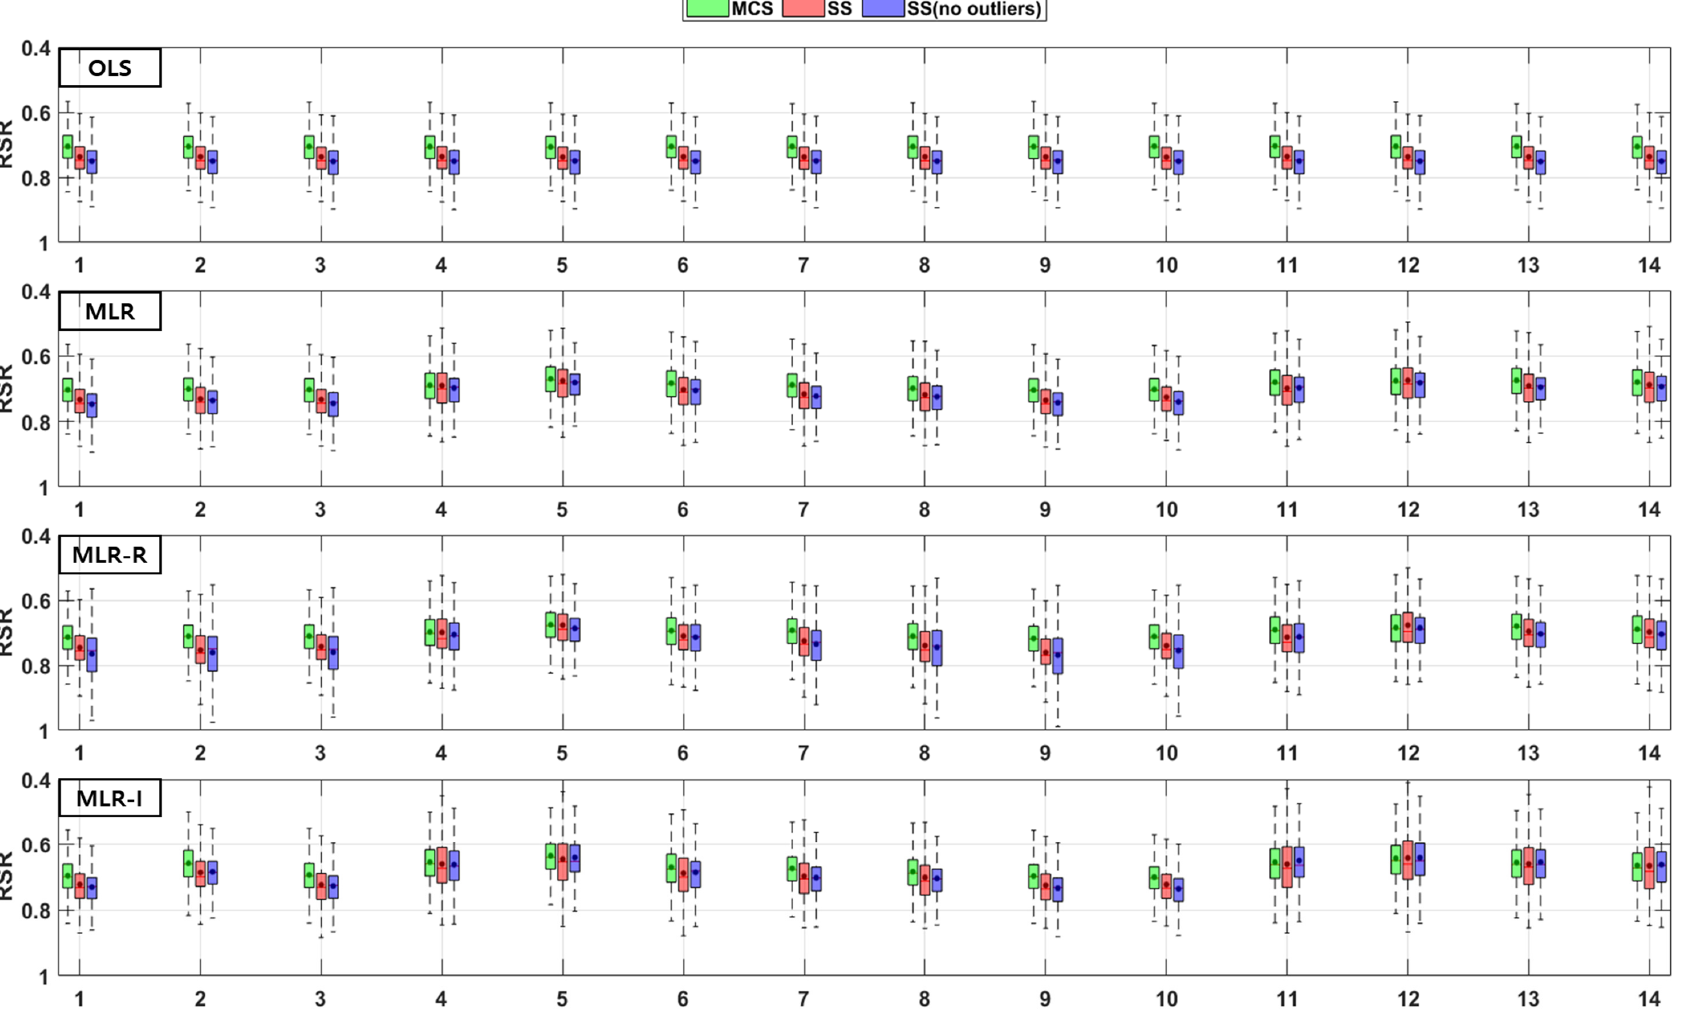
Figure 8. Error analysis (RSR) results of TP removal in detention basins.